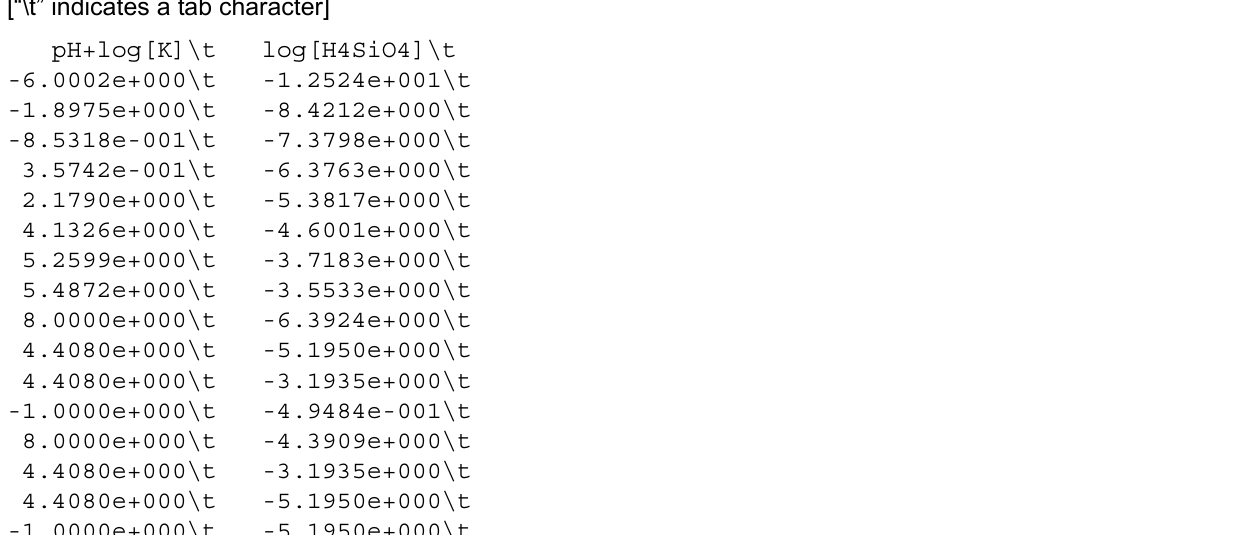
Table 25. Results written to the selected-output file by the USER_PUNCH Basic program in simulation 6C, which simulates the kinetic dissolution of